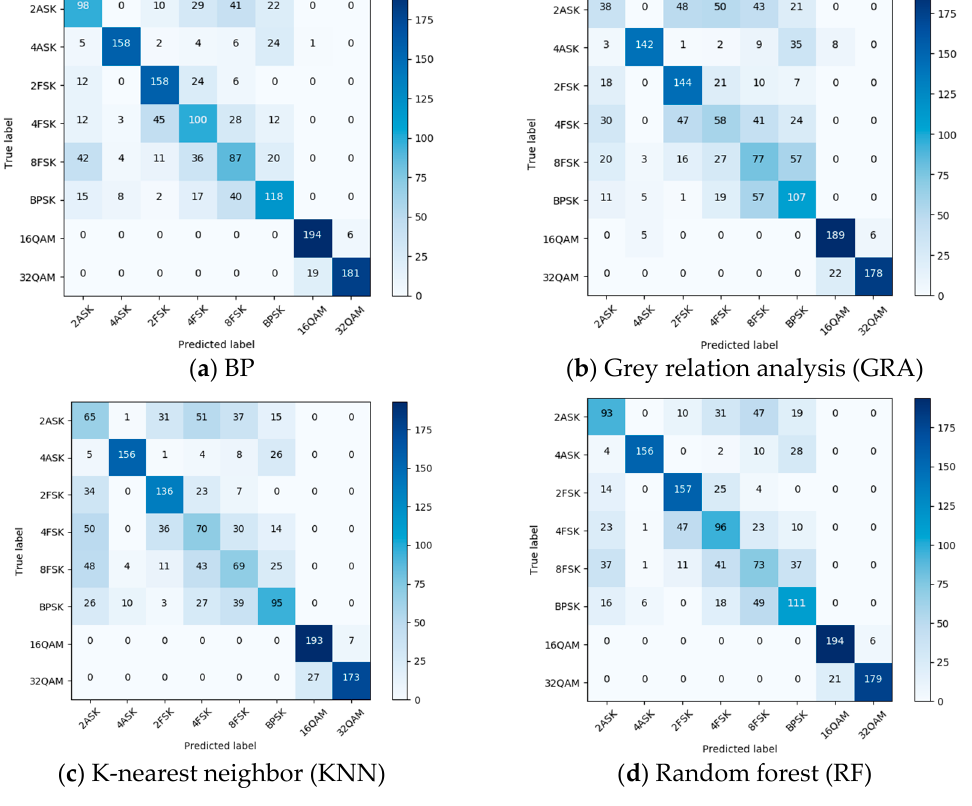
Figure 5. Confusion matrices at 0 dB signal-to-noise ratio (SNR).